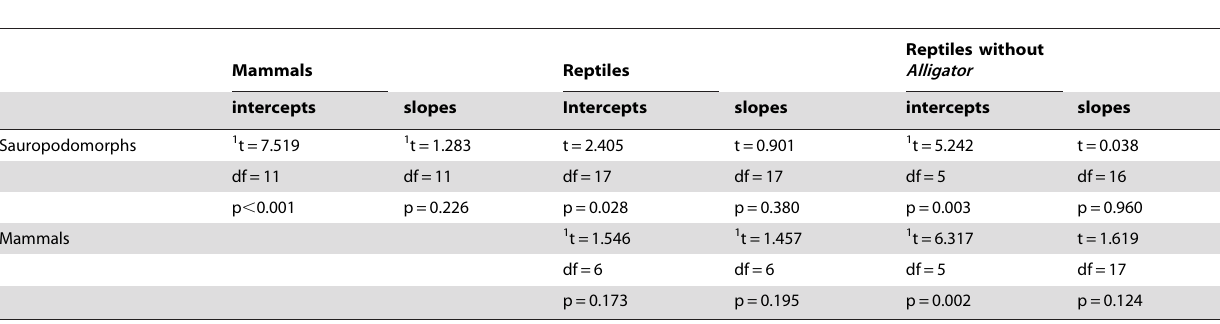
Table 4. Pairwise comparisons of the slopes and intercepts of the different regression models (sauropodomorphs, mammals, reptiles, reptiles without Alligator ). t= t-value of t-test, df =degree of freedom, p =p-value.